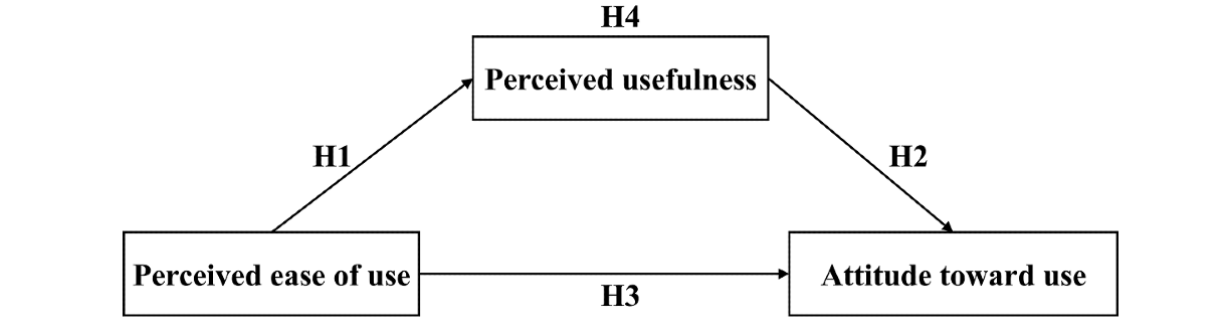
Figure 2. Proposed research model. H1: perceived ease of use and perceived usefulness are significantly positively correlated; H2: perceived usefulness is significantly positively correlated with use willingness and frequency; H3: perceived ease of use is significantly positively correlated with use willingness and frequency; H4: perceived usefulness has a mediating effect on perceived ease of use and use